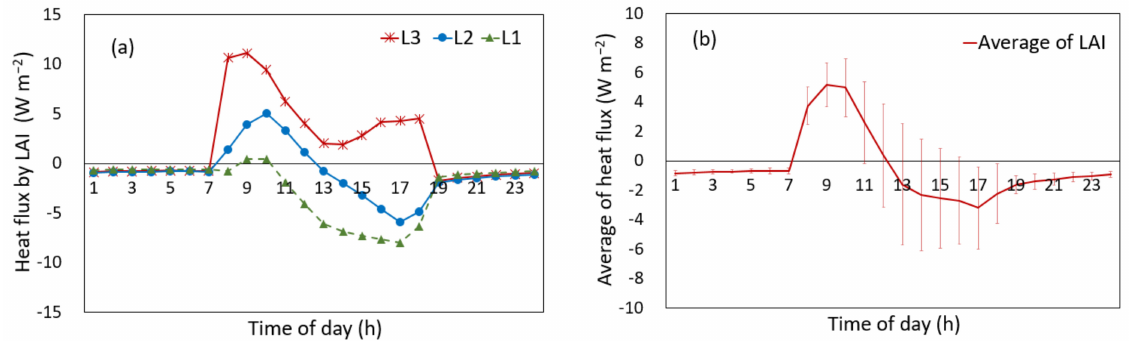
Figure 16. Heat flux between the canopy and air. ( a ) Heat flux per leaf area index (LAI); ( b ) average value for LAI3, 2, and